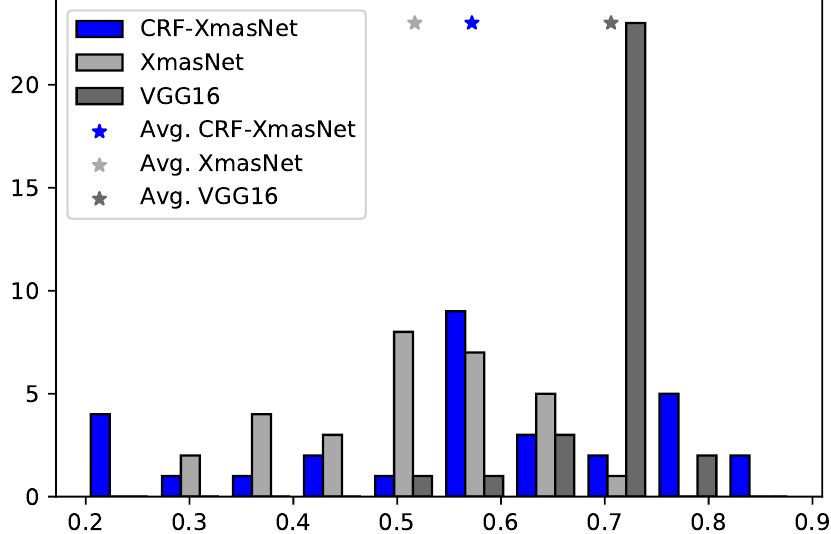
Figure 4. Bar graph with 10 groups that represent the occurrences of the test AUROC regarding XmasNet, CRF-XmasNet, and VGG16 architectures observed over 30 runs. The blue, light gray, and dark gray bars refer to the CRF-XmasNet, XmasNet and VGG16 architectures, respectively. The star markers of the same color lie on the average ROC values for the three